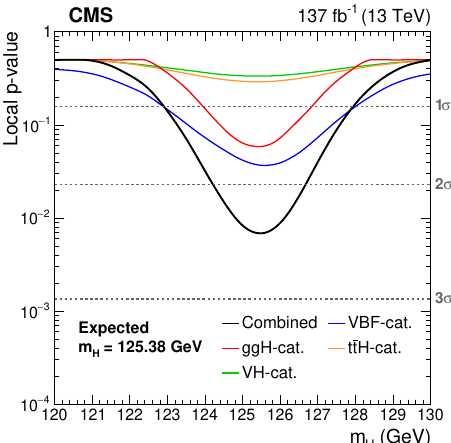
Figure 10 . Left: observed local p -values as a function of m fit as well as from each individual production category, are shown. The solid markers indicate the mass points for which the observed p -values are computed. Right: the expected p -values are calculated using the background expectation obtained from the S+B fit and injecting a signal with m = 125 . 38 GeV and µ = 1 H